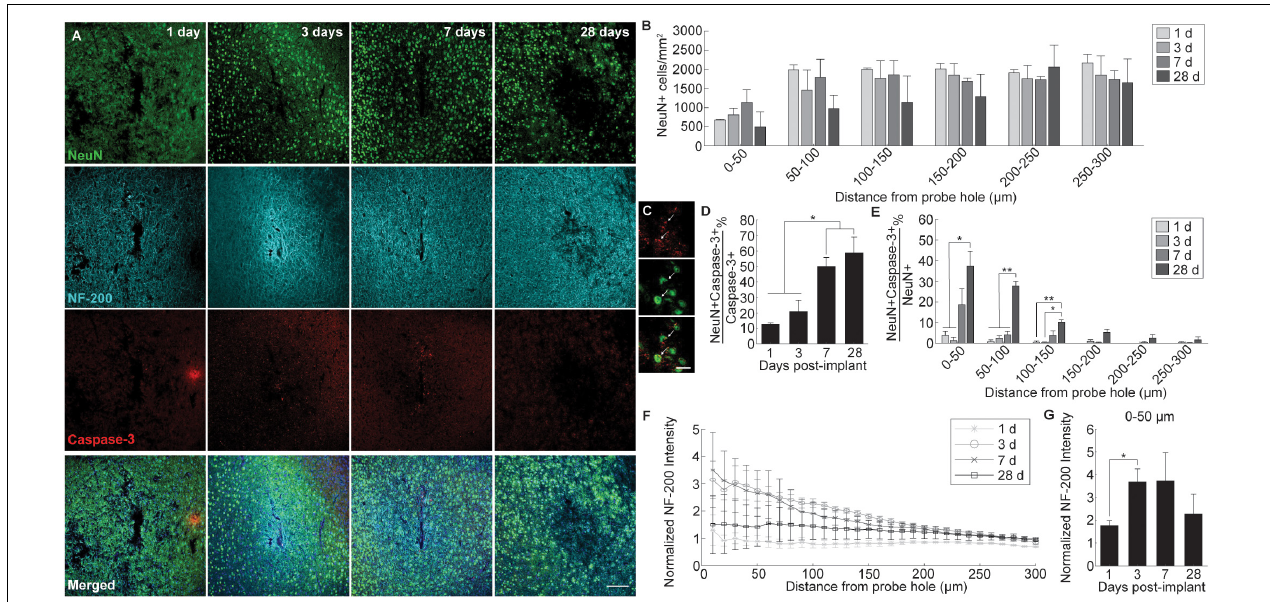
FIGURE 1 | Evaluation of neuronal cell death and axonal preservation around an implanted microelectrode array. Microelectrode implantation induces progressive neuronal loss and degeneration as well as axonal dysfunctional within close proximity of the electrode interface. (A) Representative immunohistochemical stain for neurons (NeuN), axons (NF-200), and caspase-3 at 1, 3, 7, and 28 days post-insertion. Scale bar = 100 µ m. (B) NeuN+ cell counts within 50 µ m bins up to 300 µ m away from the probe hole demonstrating reduced neural density near the site of probe insertion. Notably, neuronal density is most disrupted within 0–100 µ m from the probe hole at each time point. (C) Magnified images of Caspase-3+ staining (top), NeuN+ cells (middle), and co-labeled NeuN+Caspase-3+ cells (bottom). White arrows denote co-localized cells. Scale bar = 20 µ m. (D) Percent of NeuN+Caspase-3+ cells over total Caspase-3+ cells within 300 µ m from the probe hole. (E) Increases in percent of NeuN+Capase-3+ cells over total NeuN+ cells within 50 micron bins up to 300 µ m away from the probe hole demonstrate significant neurodegeneration near the site of implantation. (F) Axonal reorganization is presented as normalized NF-200 intensity within 10 µ m bins up to 300 µ m away from the probe hole. (G) Normalized NF-200 intensity averaged over the first 50 µ m from the probe hole highlights significant temporal differences in axonal integrity near the site of insertion. Pattern of axonal intensity matches fluctuations in neuronal density over time within 0–50 µ m distance from probe hole. ∗ indicates p < 0.05. ∗∗ indicates p <